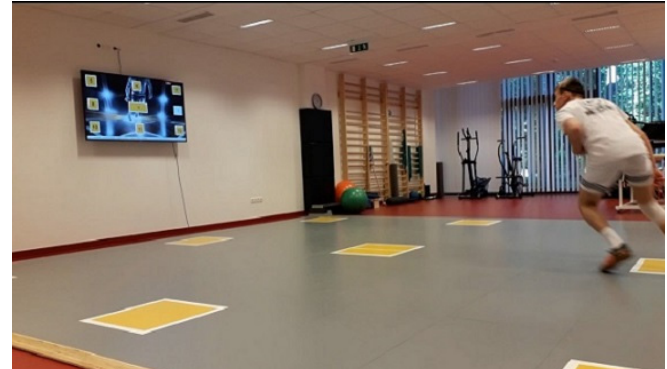
Figure 5. 60 m chasing test.